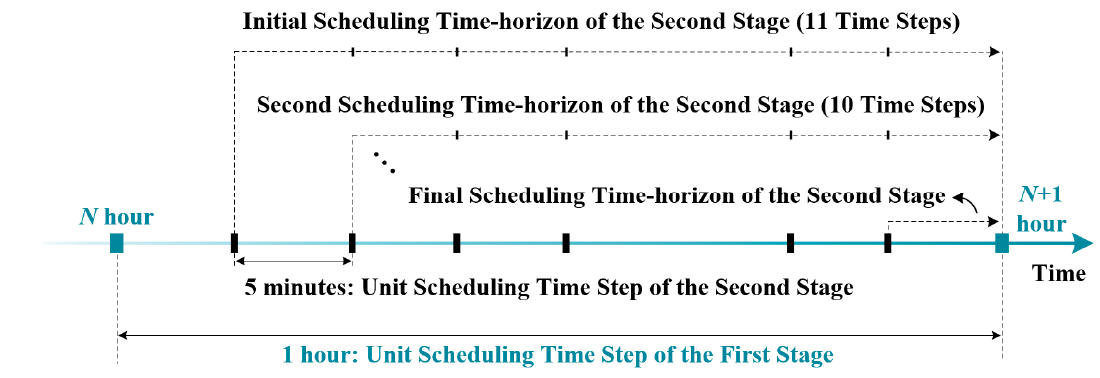
Figure 4. Timeframe of the two-stage ED strategy.